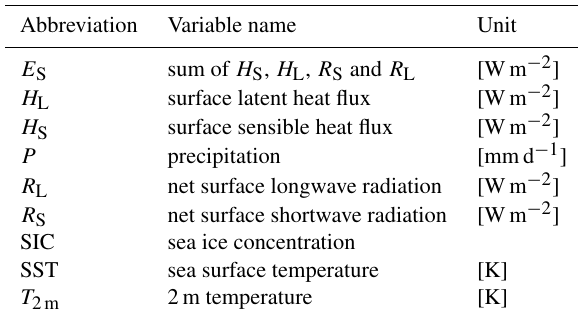
Table 1. List of variable names used in this